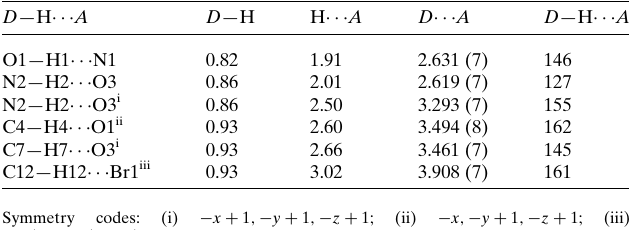
Table 1 Hydrogen-bond geometry (A˚ , (cid:2) ).